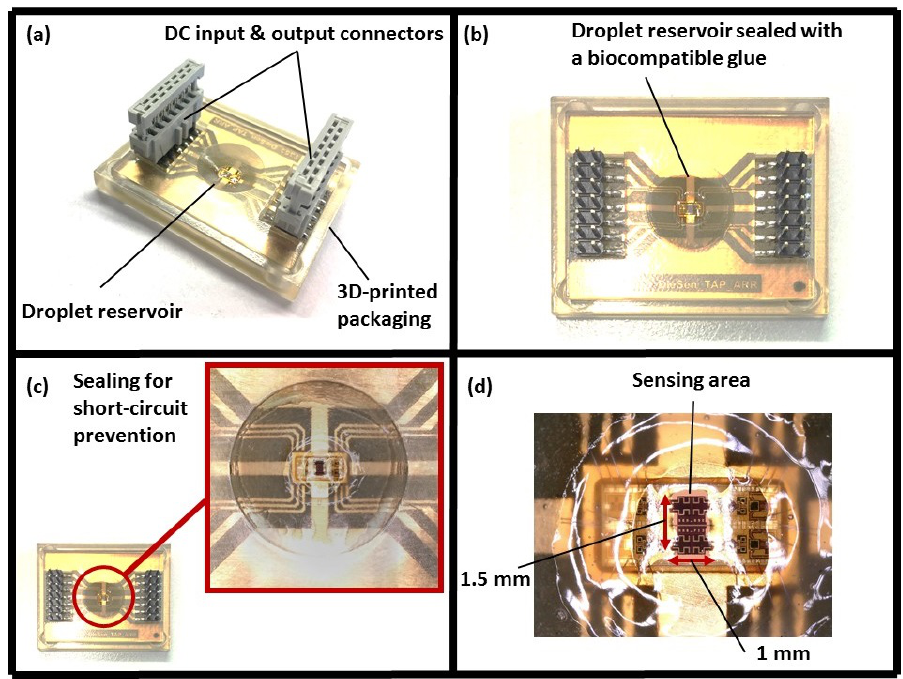
Figure 4. ( a ) The sensor packaging, ( b ) droplet reservoir, ( c ) sealing of the reservoir for prevention of liquids spreading, ( d ) remaining sensing area after the sealing